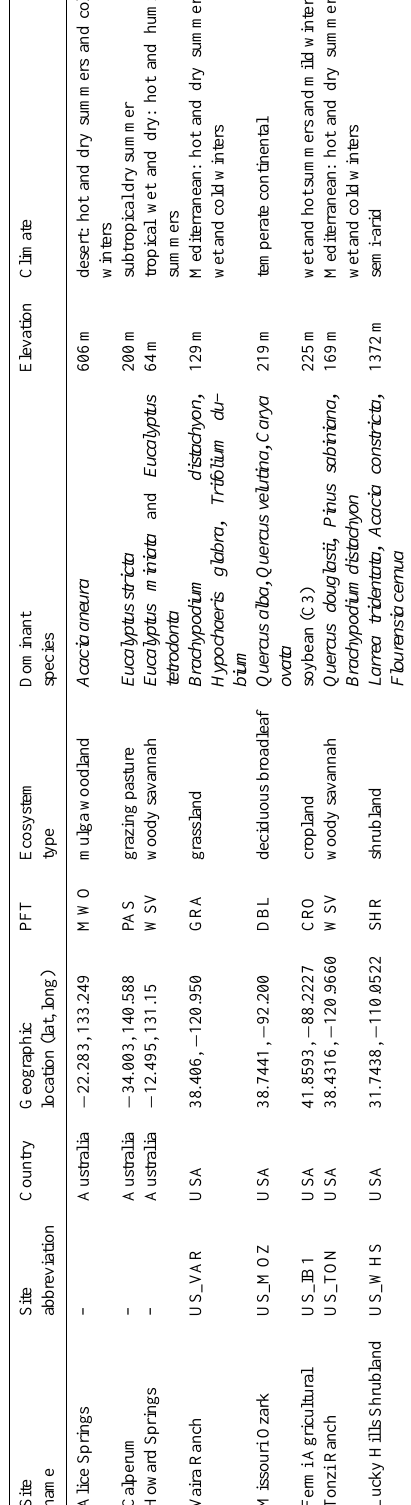
Fig. 2, where the distribution of points within the feature space were predominantly centred on the 1 : 1 line, showing a strong relationship between both